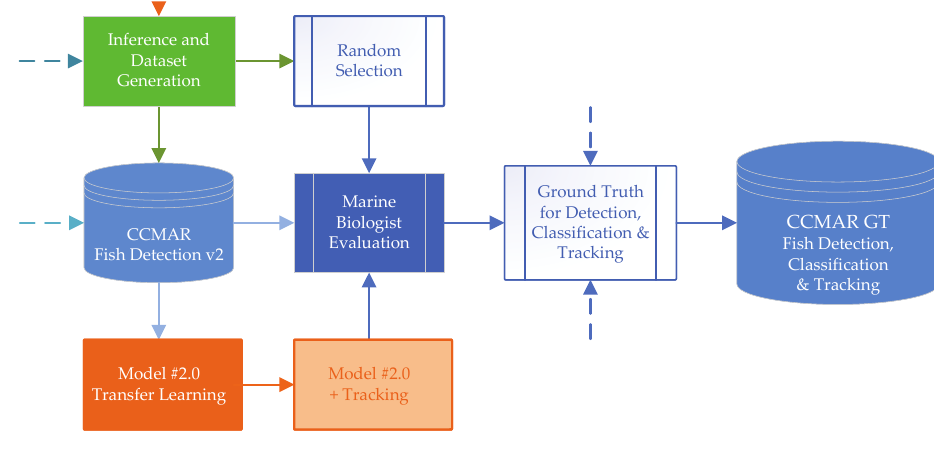
Figure 7. Future